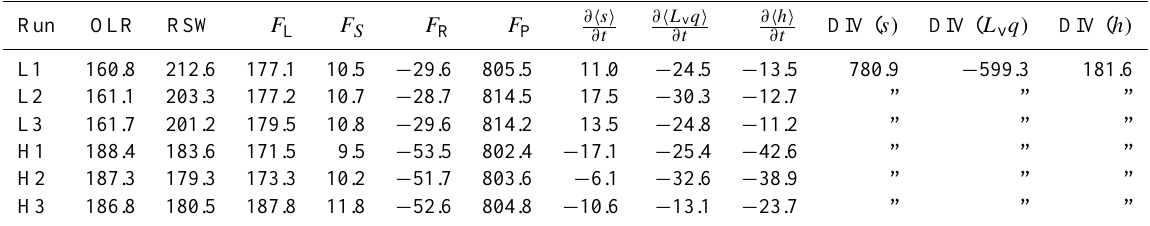
Table 1. OLR, RSW, and terms in the vertically-integrated s , q , and h budgets from Eqs. (4–6) for the three low-OLR (L1, L2, L3) and three high-OLR (H1, H2, H3) ensemble members with pristine aerosols. Presented quantities are averaged between 12:00UTC 19 January and 12:00UTC 25 January. DIV ( s) , DIV ( L v q) , and DIV ( h) are the vertically-integrated imposed large-scale 3-D advection of s , L v q , and h , and are identical in all simulations. Units are Wm − 2